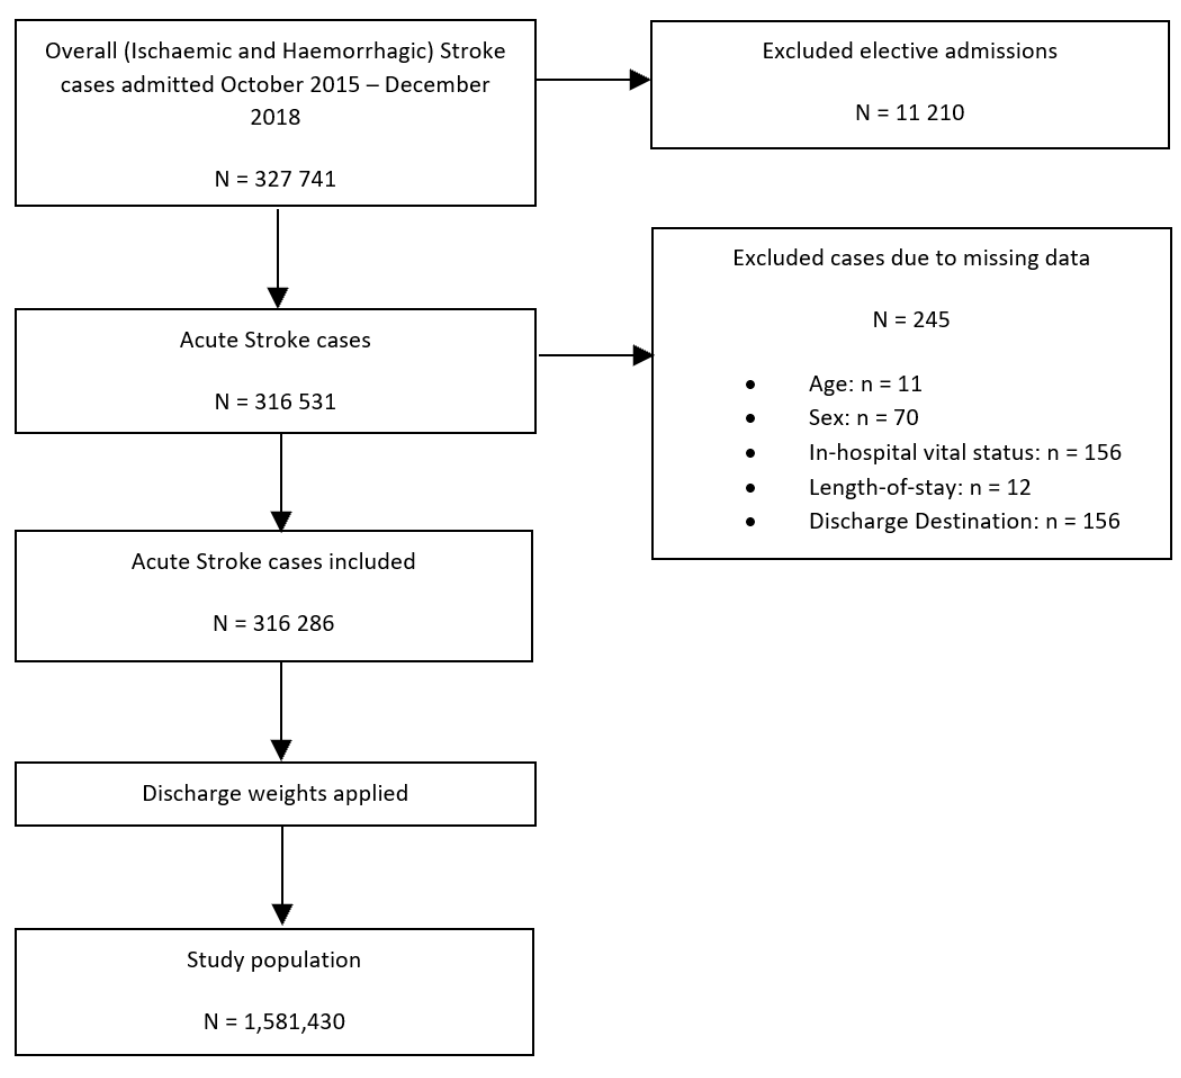
Figure 1. Patient population flowchart detailing the cohort included in the primary analysis assessing the association between co-morbid SLE and all in-hospital outcomes amongst patients with ischaemic and haemorrhagic stroke.